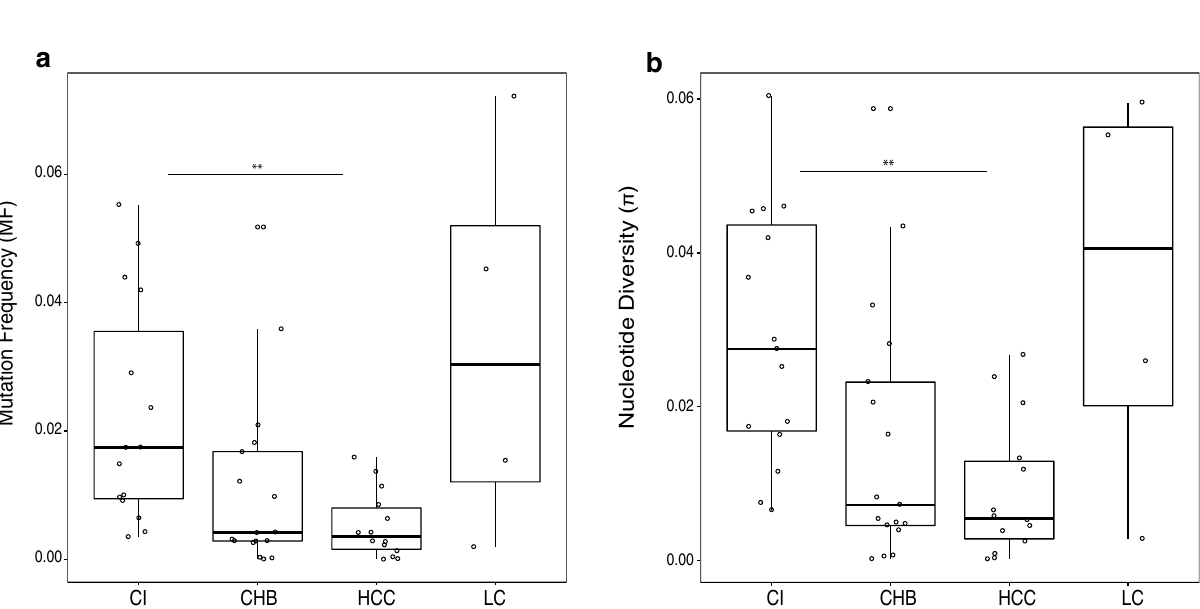
Figure 1. Mutation frequency (Mf) and population nucleotide diversity (π) comparisons. Boxplots show comparisons of Mf ( a ) and π ( b ) values between the 4 clinical groups. Each dot represents a single patient. Asterisks above the boxes denote specific p values (2 asterisks < 0.01) obtained by performing the Kruskal–Wallis test plus Dunn posthoc test and adjusted with the Bonferroni correction. CHB chronic hepatitis B; CI chronic infection, HCC hepatocellular carcinoma, LC liver